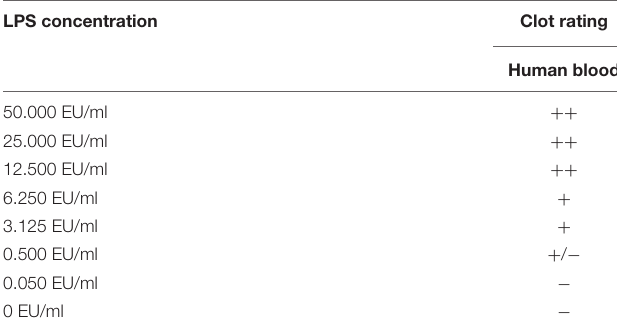
TABLE 1 | Summary of gel clot assays for LPS detection in human